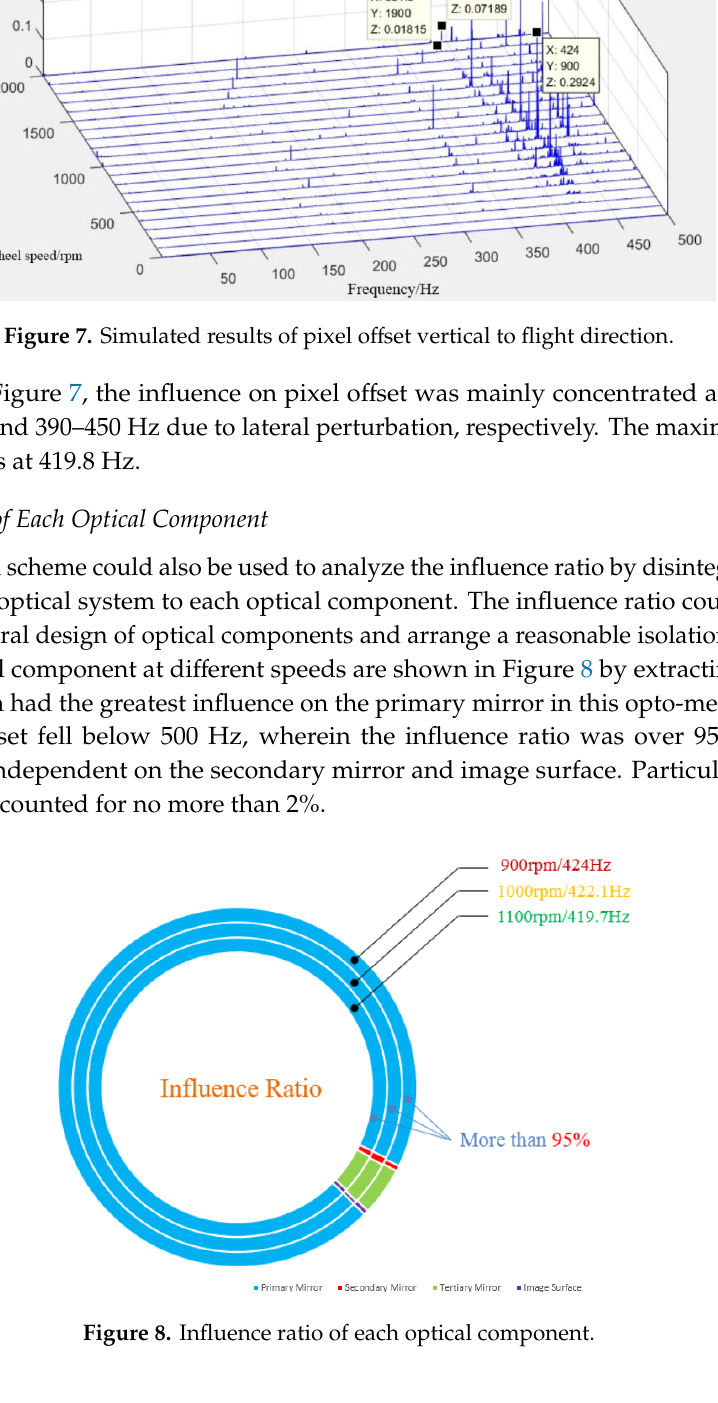
Figure 6. The lift-off vibration test of the satellite.